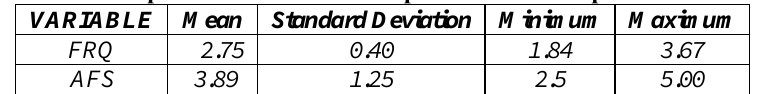
Table 2. Descriptive Statistics of the Dependent and Independent Variable